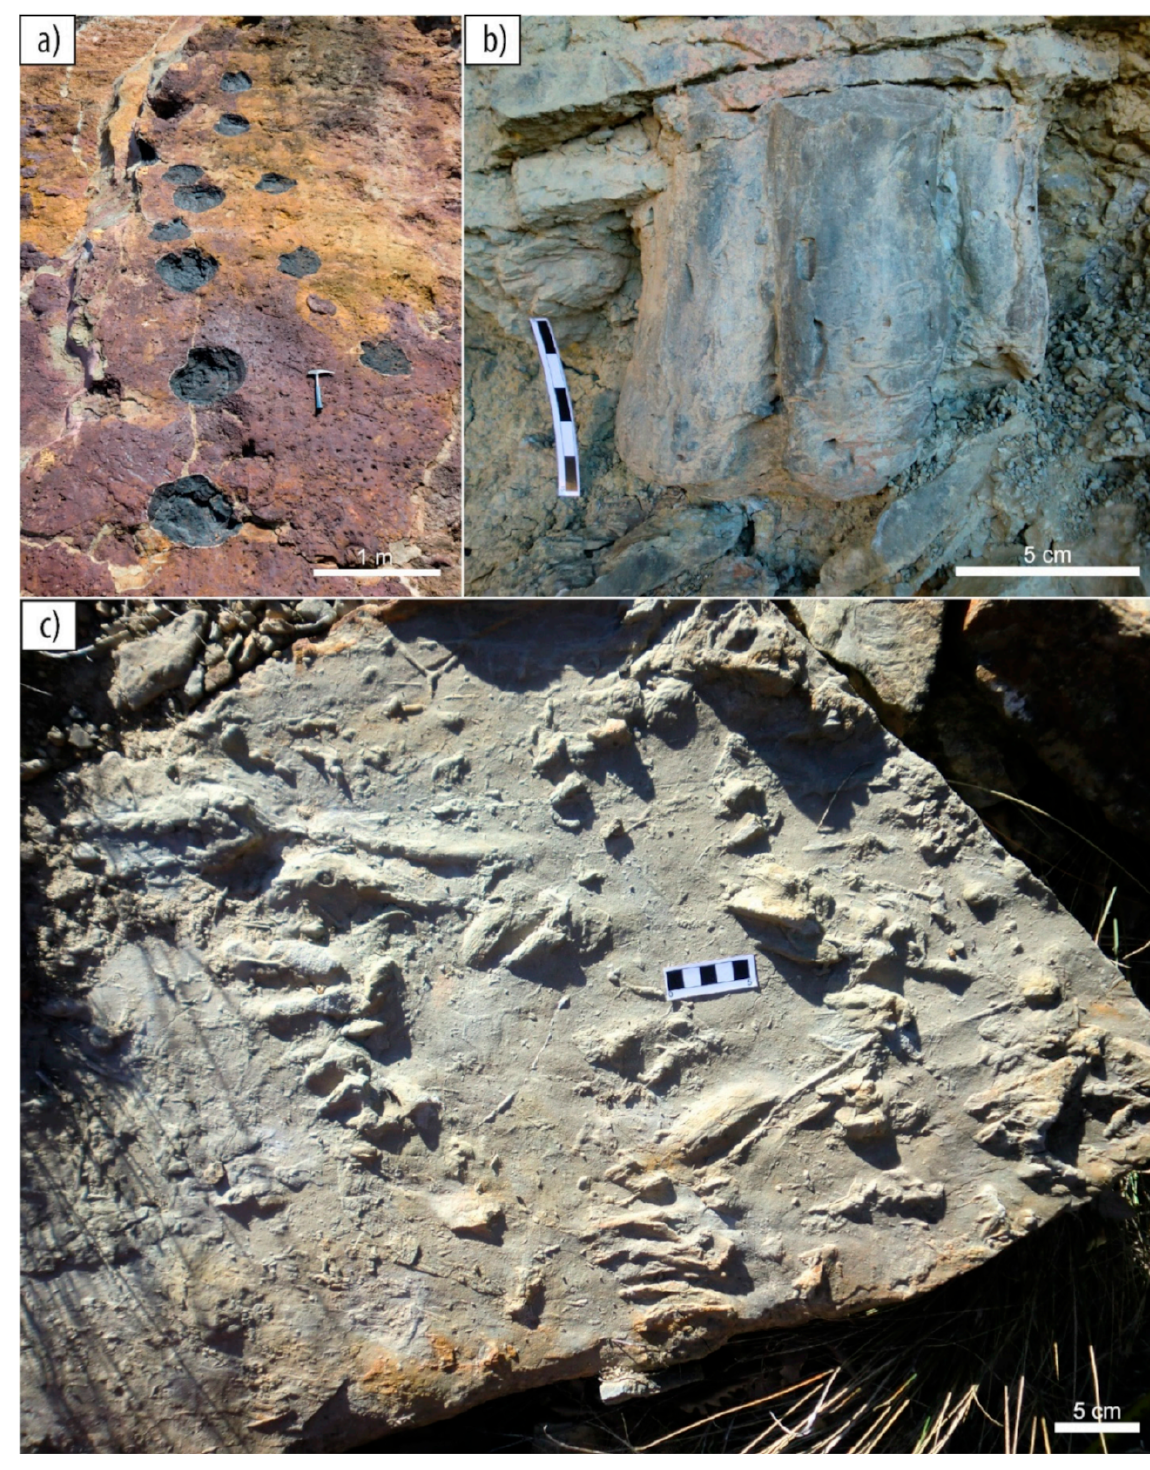
Figure 5. Tetrapod tracks from the Western Tremp Syncline. ( a ) Hadrosauropodus trackway from the Areny 1 site; ( b ) foot cast of a hadrosaurid dinosaur from the 172-i/04/a site; ( c ) crocodylomorph tracks from the Serraduy Norte